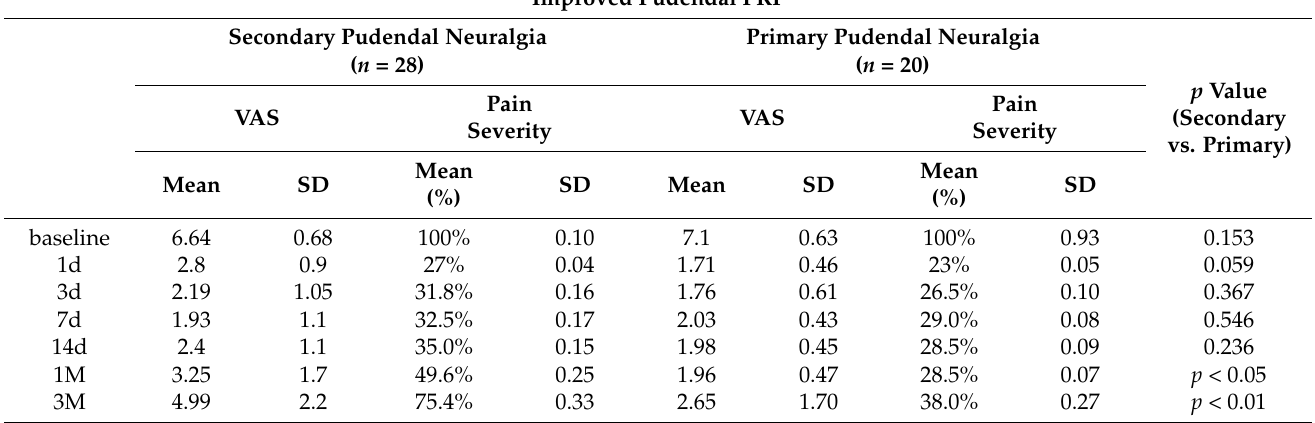
Table 4. Changes in VAS and pain severity between the secondary and primary pudendal neuralgia in the PRF treatment group. PRF = pulsed radiofrequency, VAS = Visual Analog Scale, D = day, M = month.